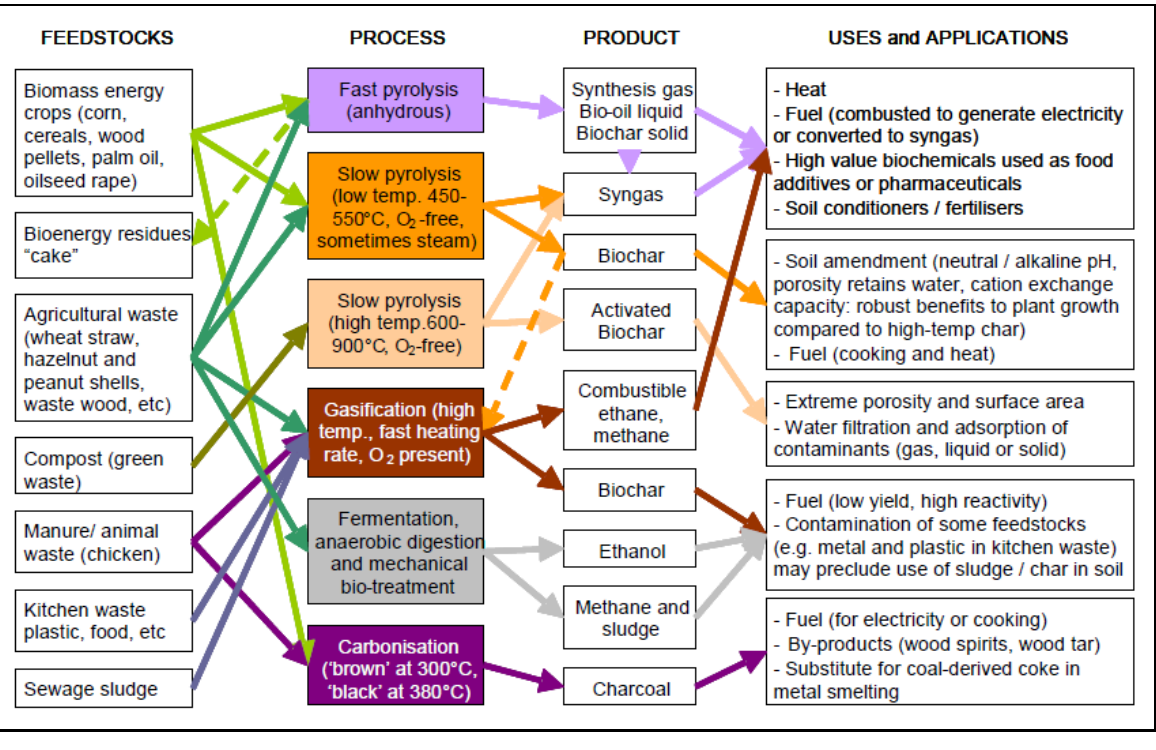
Figure 1. Summary of common biochar feedstocks, typical products, applications and uses of these products. Note: this figure is reproduced with permission from [25].